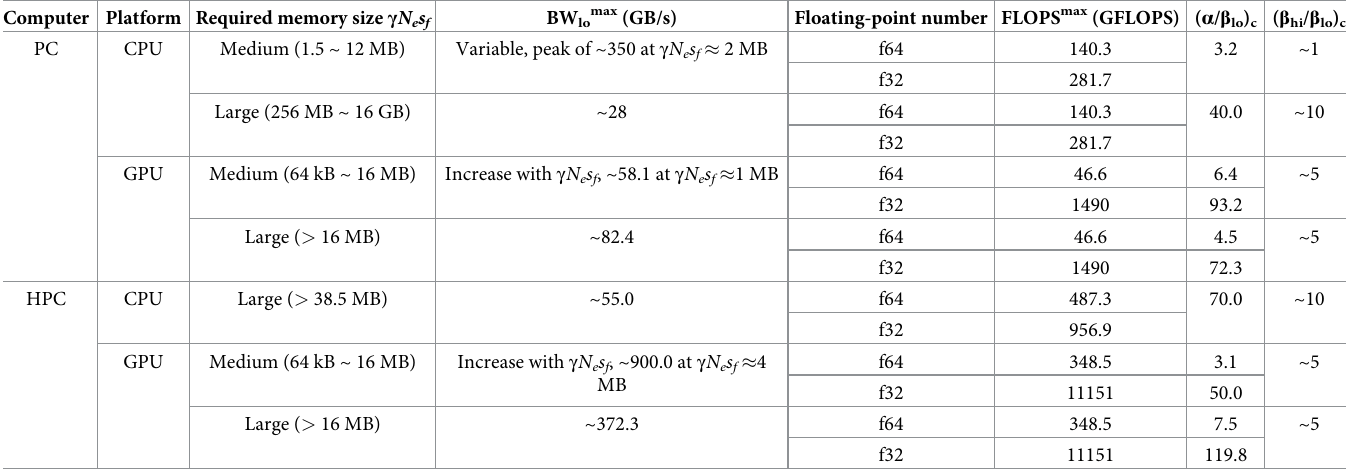
Table 6. Hardware parameters of optimal implementations.